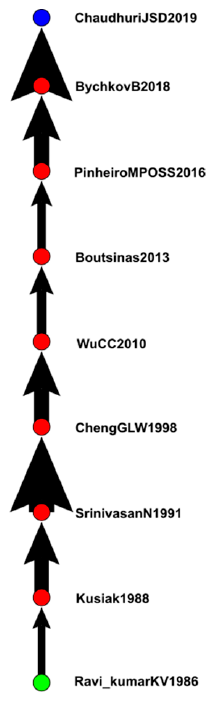
Figure 8. Global main path of FMS fl exibility measurement.